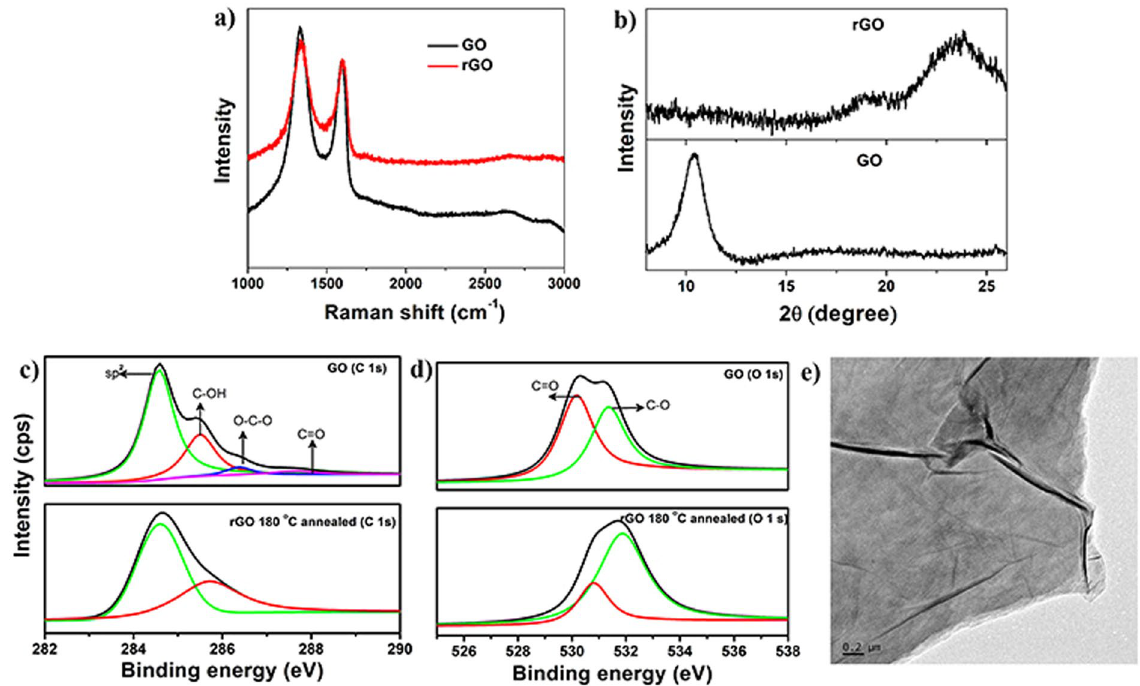
Figure 1. ( a ) Raman spectra of unstrained GO before and after annealing. ( b ) X-ray diffraction spectra of GO and rGO; High resolution (c) C1s and (d) O1s XPS spectra for GO and rGO. ( e ) TEM image of rGO